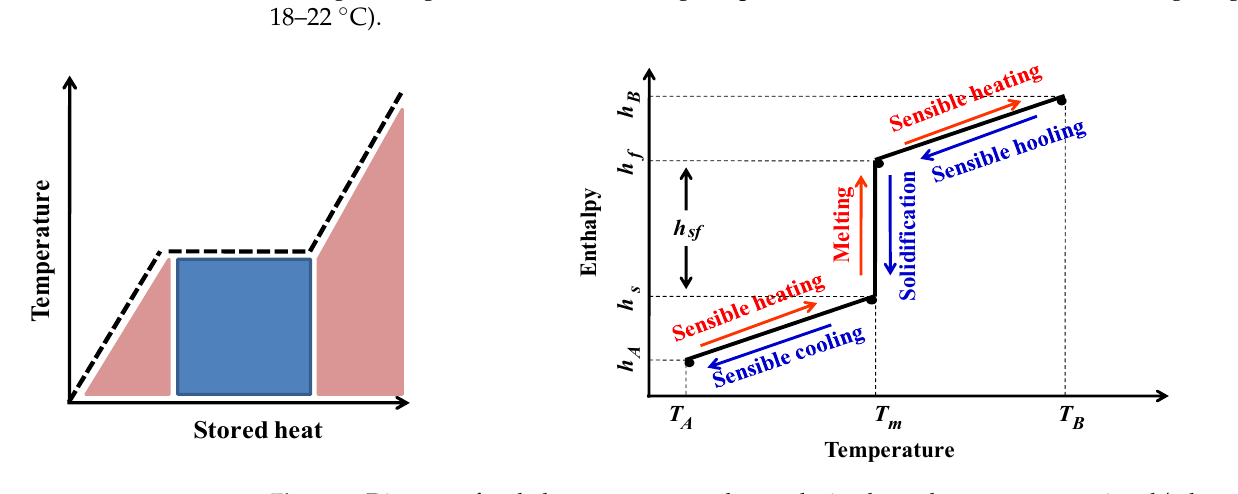
Figure 8. Diagram of enthalpy–temperature change during latent heat storage, reprinted/adapted with permission from Refs. [3,28], 2022, Springer Nature and Elsevier.